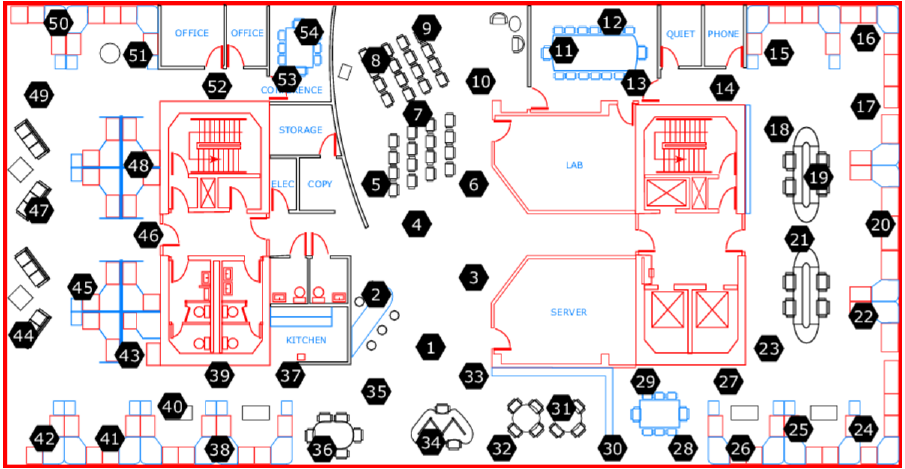
Figure 9. Wireless sensor network (WSN) setup in the Intel Berkeley Research Lab.